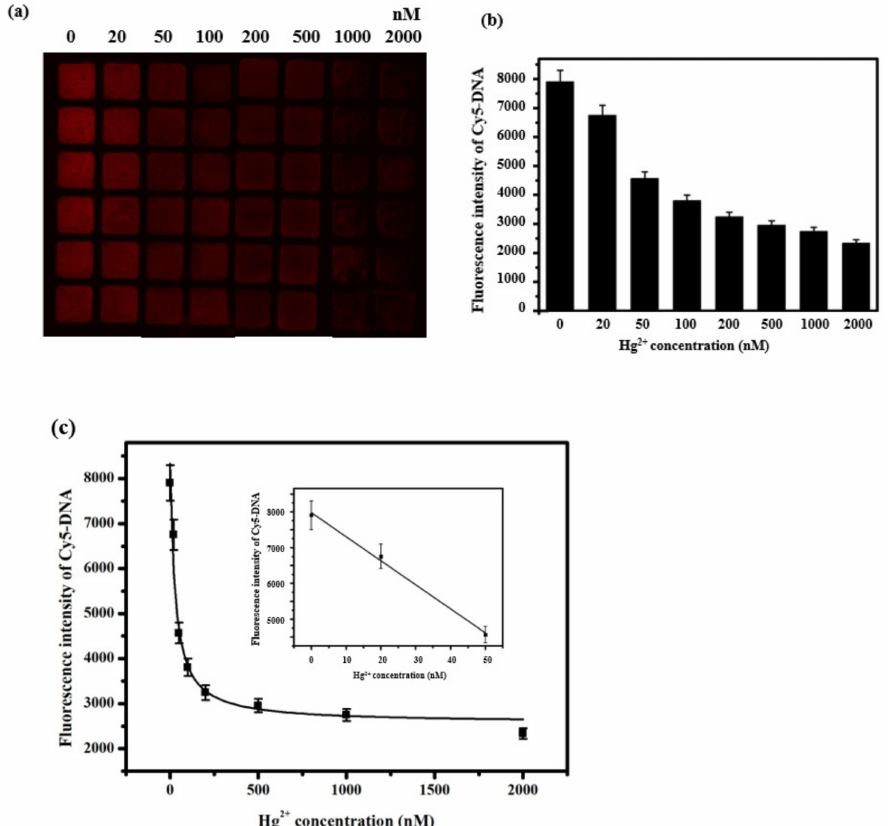
Figure 3. Sensitivity analysis for Hg 2+ detection based on sensors containing DNA sequence I hybrid with one PS cutting site. ( a ) Scanning image of the chip array after adding different concentrations of Hg 2+ . ( b )The fluorescence intensity of the Cy 5-DNA in the presence of different concentrations of Hg 2+ . ( c ) Plotted data extracted from ( b ). The inset shown in ( c ) represents the linear working curve with the average of 3 experiments at low mercury ion